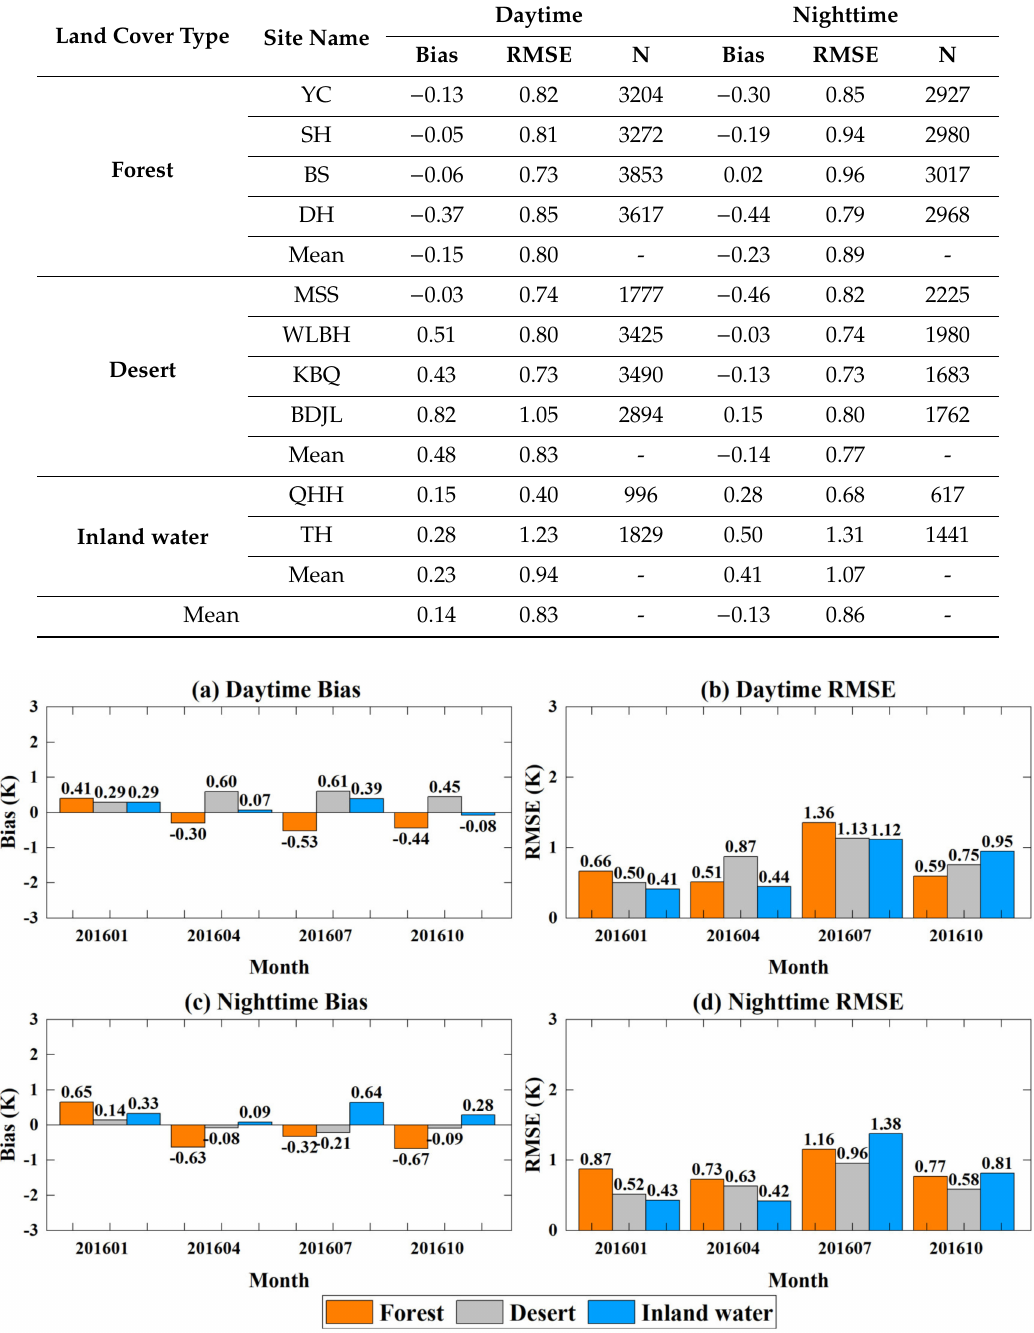
Figure 5. The biases and RMSEs of the di ff erences between AHI LSTs and R-based LSTs in di ff erent months during the daytime and nighttime for the forest, desert, and inland water validation